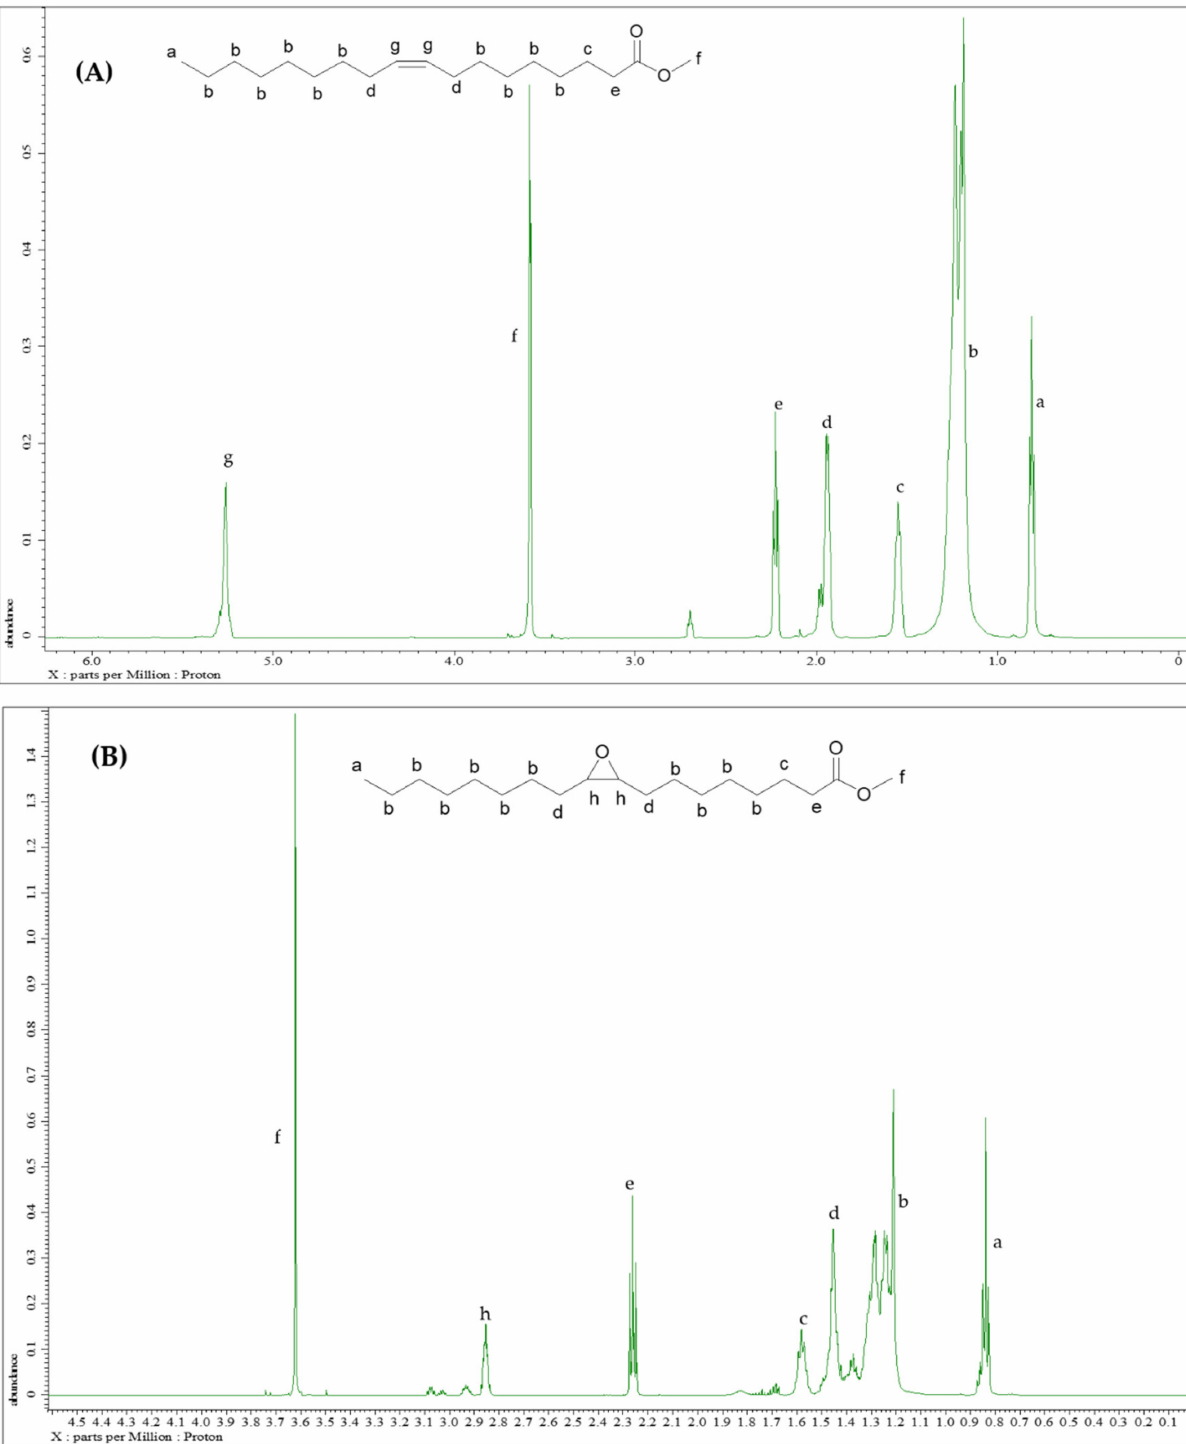
Figure 3. Proton NMR Spectra of ( A ) Methyl oleate and ( B ) Epoxidised methyl oleate